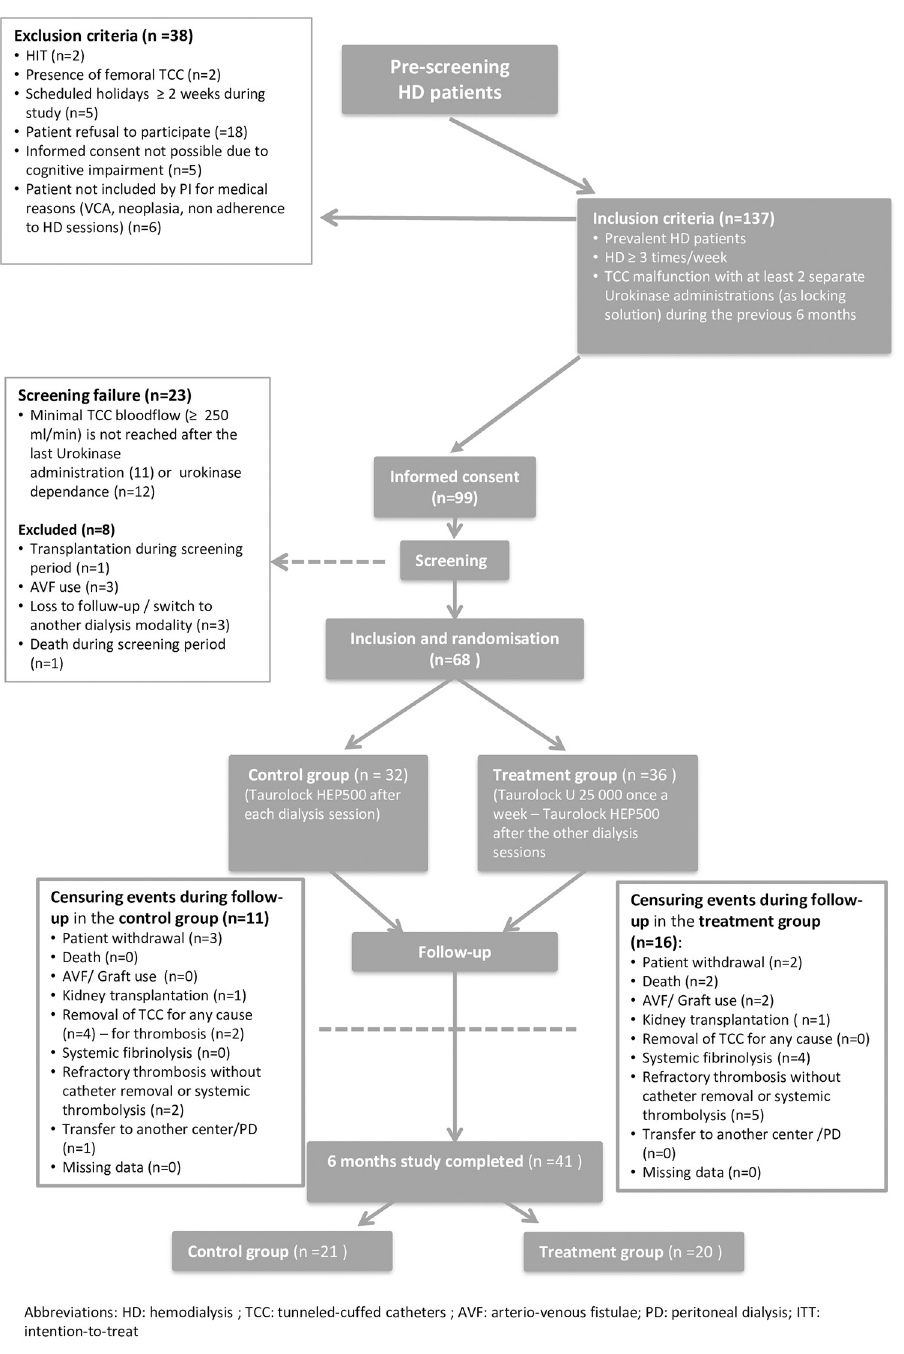
Fig 1. Flow chart of the study. Patients who developed a censuring event during the follow up period contributed to the study until the date of the occurrence of the censoring event.